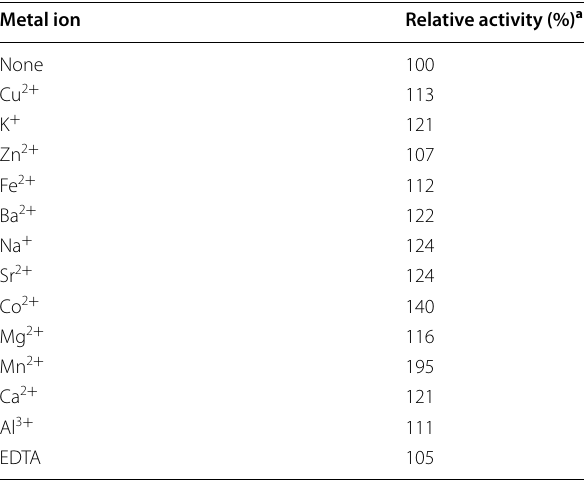
Table 1 Effects of various metal ions and EDTA on rAgaB-4 activity